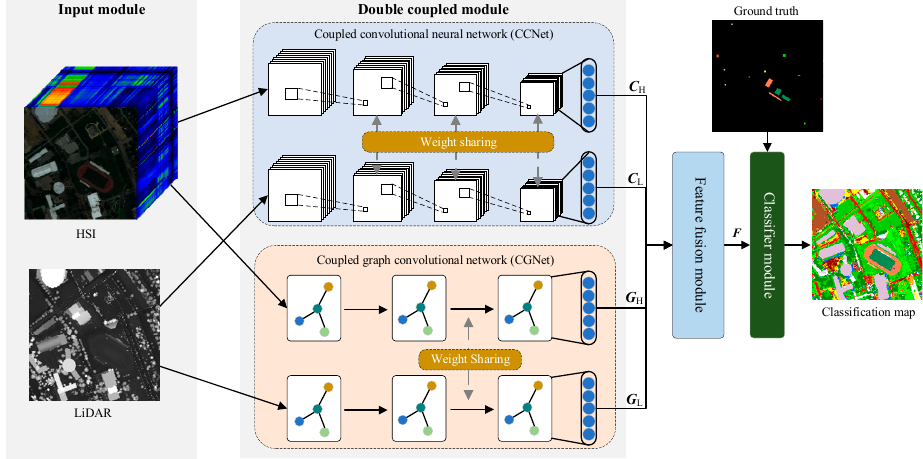
Figure 1. A general framework of proposed DCCG.